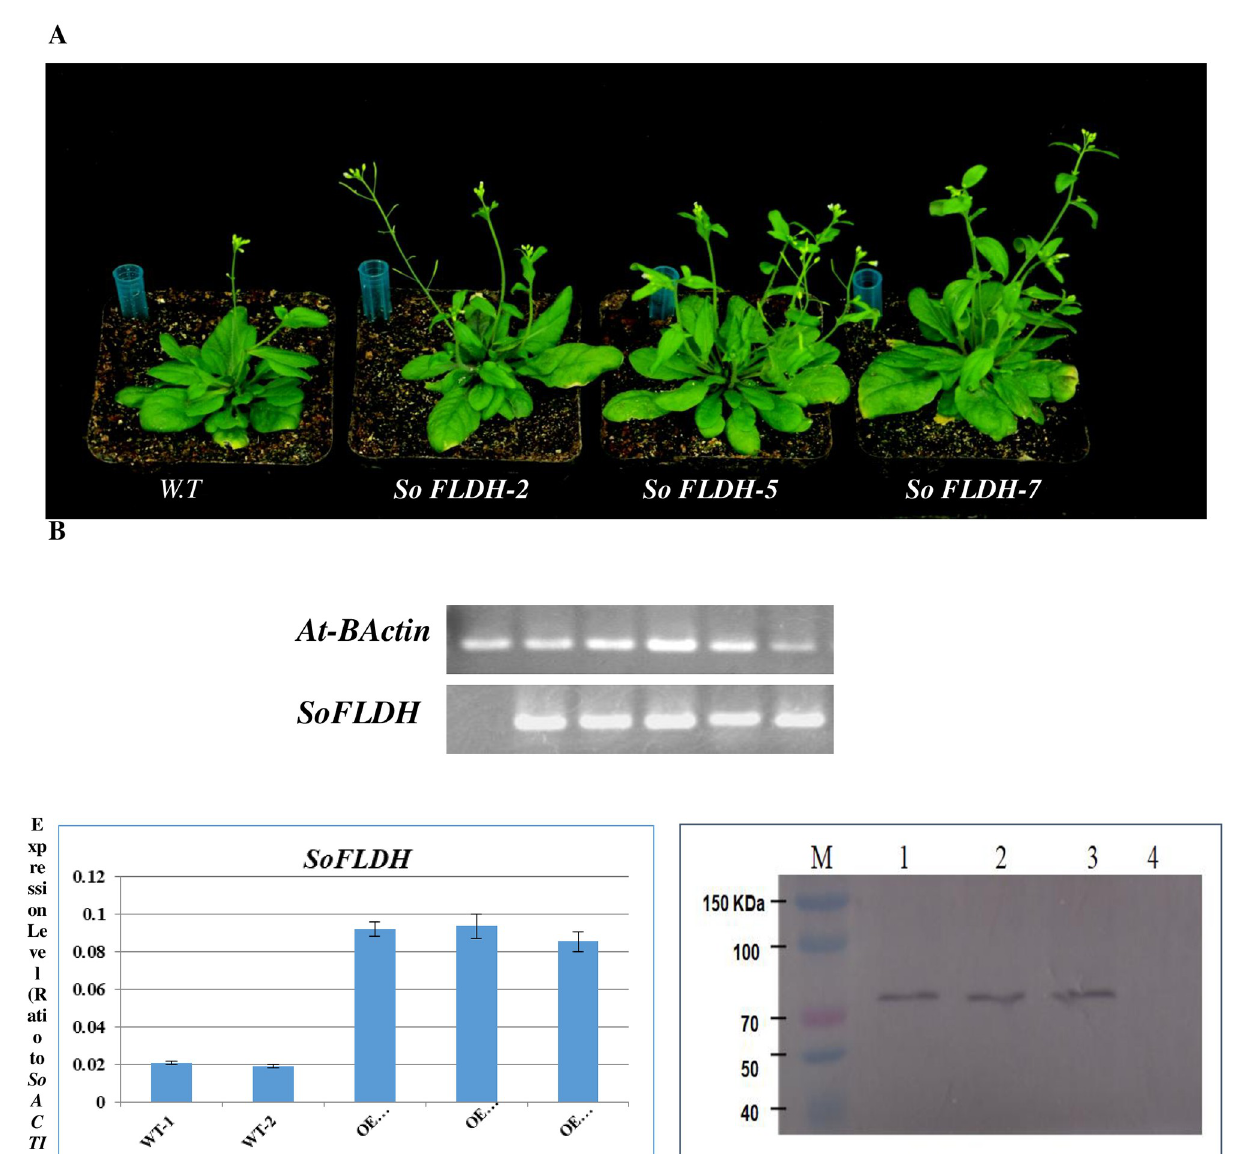
Fig 6. Overexpression of SoFLDH gene in transgenic Arabidopsis. (A) Comparison of the phenotypes of the transgenic and wild type A . thaliana . (B) Semiquantitative RT-PCR to confirm the expression of terpenoid genes. (C) Quantitative RT-PCR validation of expression of SoFLDH gene from wild- type and transgenic A . thaliana lines. (D) Western blotting (WB) detection of SoFLDH protein in transgenic and wild-type A . thaliana , the first left- hand most lane represent molecular marker proteins (M), OE-SoFLDH-2 (lane 1), OE-SoFLDH-5 (lane 2), OE-SoFLDH-7 (lane 3) and wild-type (W.T; lane